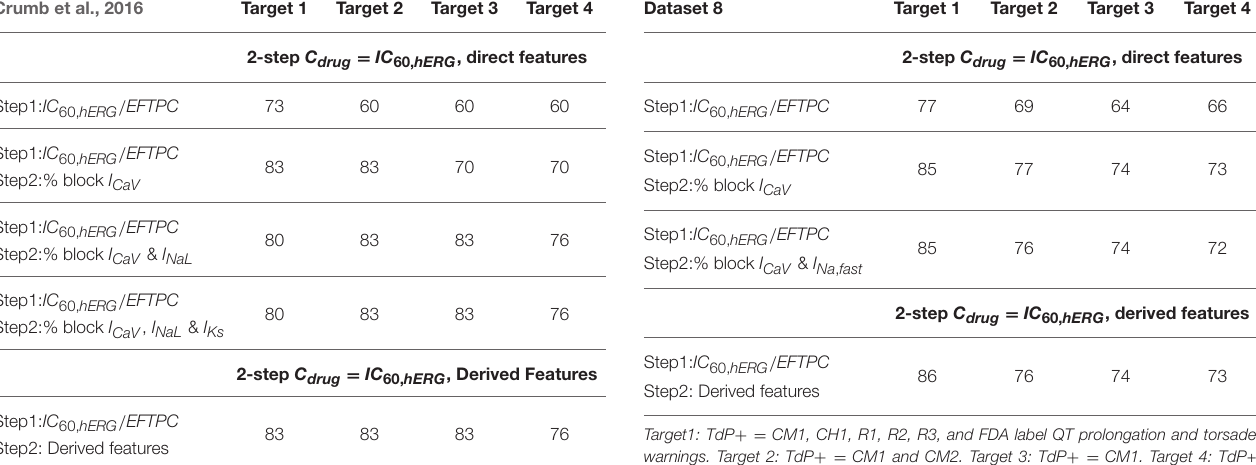
TABLE 5 | Accuracy scores of TdP classifiers on the direct features for Dataset 5 under four different TdP definitions. Crumb et al., 2016